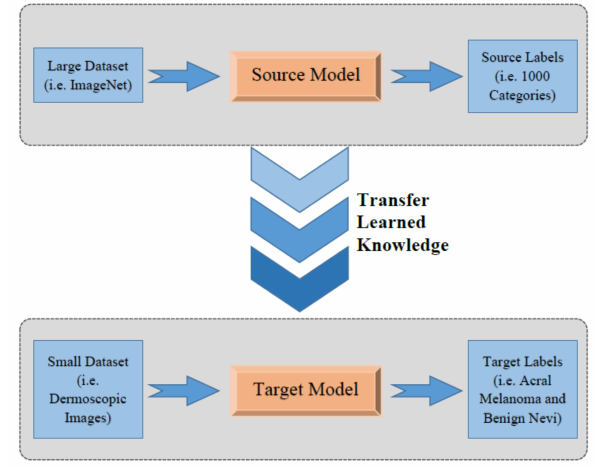
Figure 1. Concept of transfer